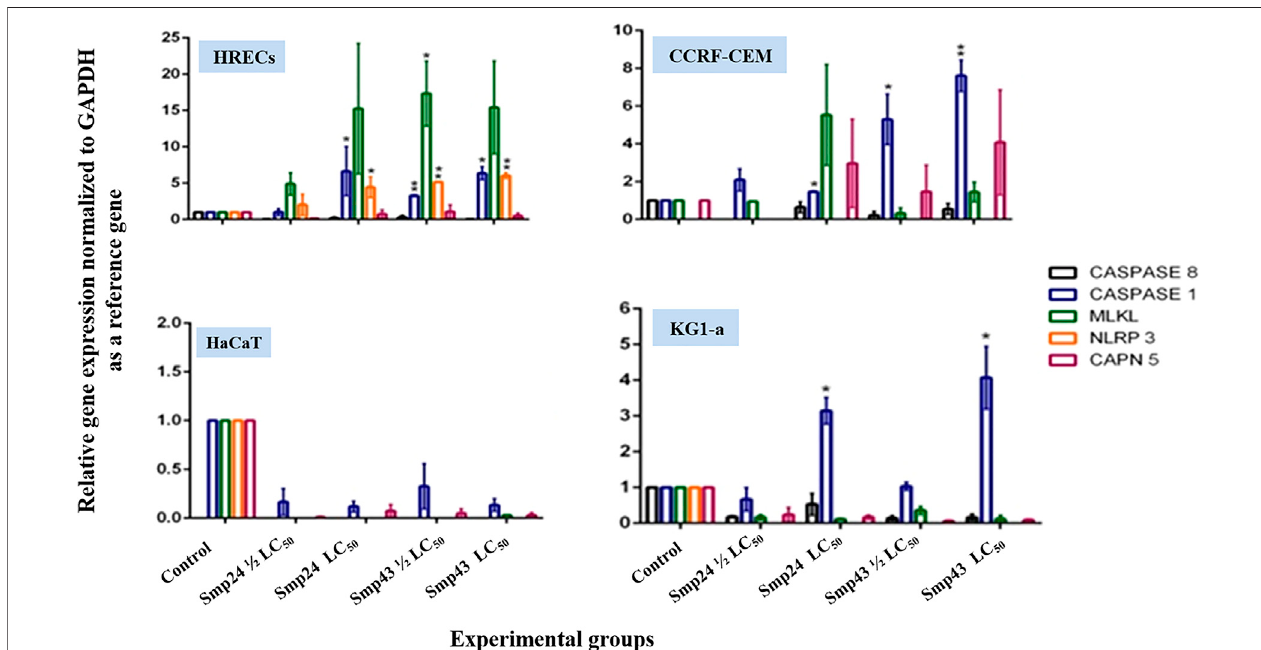
FIGURE 3 | Charts showing relative genes expressions quanti fi ed by a qRT-PCR after treating non-tumour (HRECs and HaCaT) and tumour (CCRF-CEM and KG1-a)celllines,withSmp24andSmp43.Allgeneexpressionswerenormalizedtotheexpressionofthehousekeepinggene,GAPDH.Thedatarepresentedasmean ± SE. The statistical signi fi cance (* p ≤ 0.05, ** p ≤ 0.001) was determined by comparison with the control using student